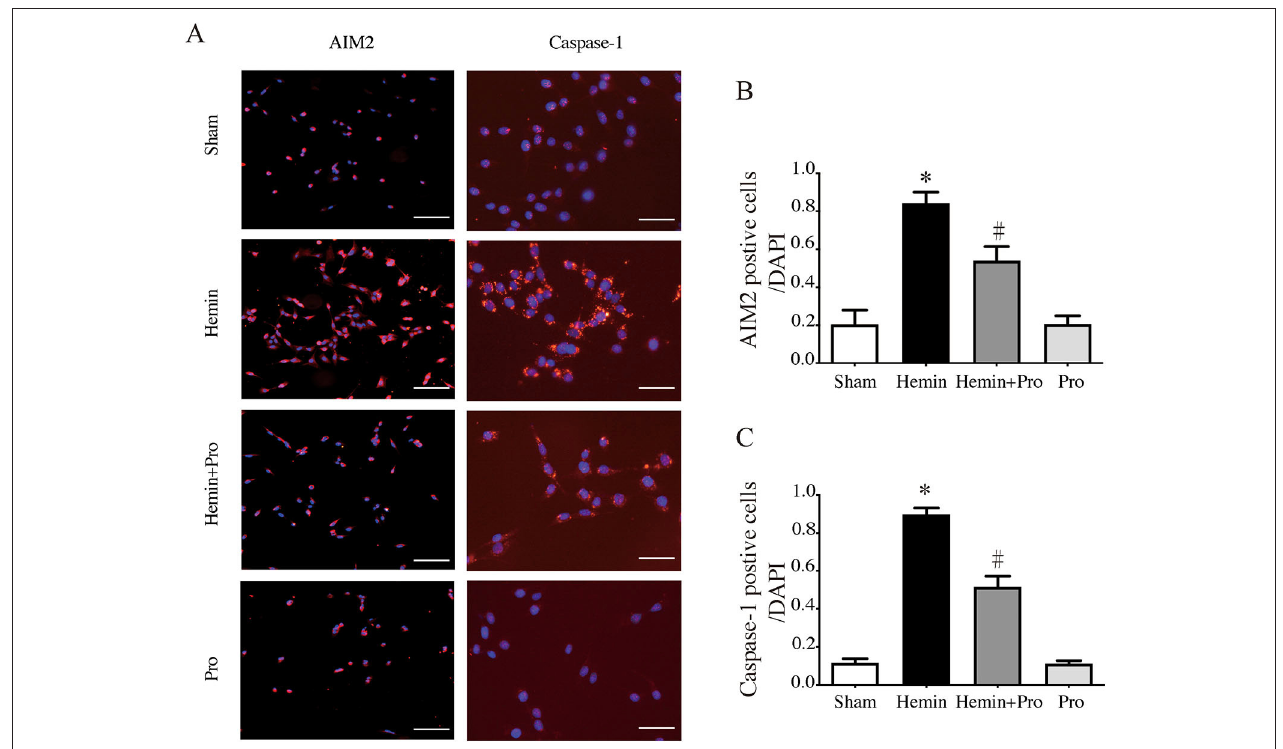
FIGURE 5 | (A) Representative micrographs showing immunofluorescence labeling of AIM2 and caspase-1 in cultured HT22 cells of sham, hemin, hemin + pro, and pro groups. Left scale bar = 100 µ m, right scale bar = 50 µ m. (B) The proportion of AIM2-positive cells in sham, hemin, hemin + pro, and pro groups. * p < 0.05 vs. sham group, # p < 0.05 vs. hemin group. (C) The proportion of caspase-1-positive cells in sham, hemin, hemin + pro, and pro group. * p < 0.05 vs. sham group, # p < 0.05 vs. hemin